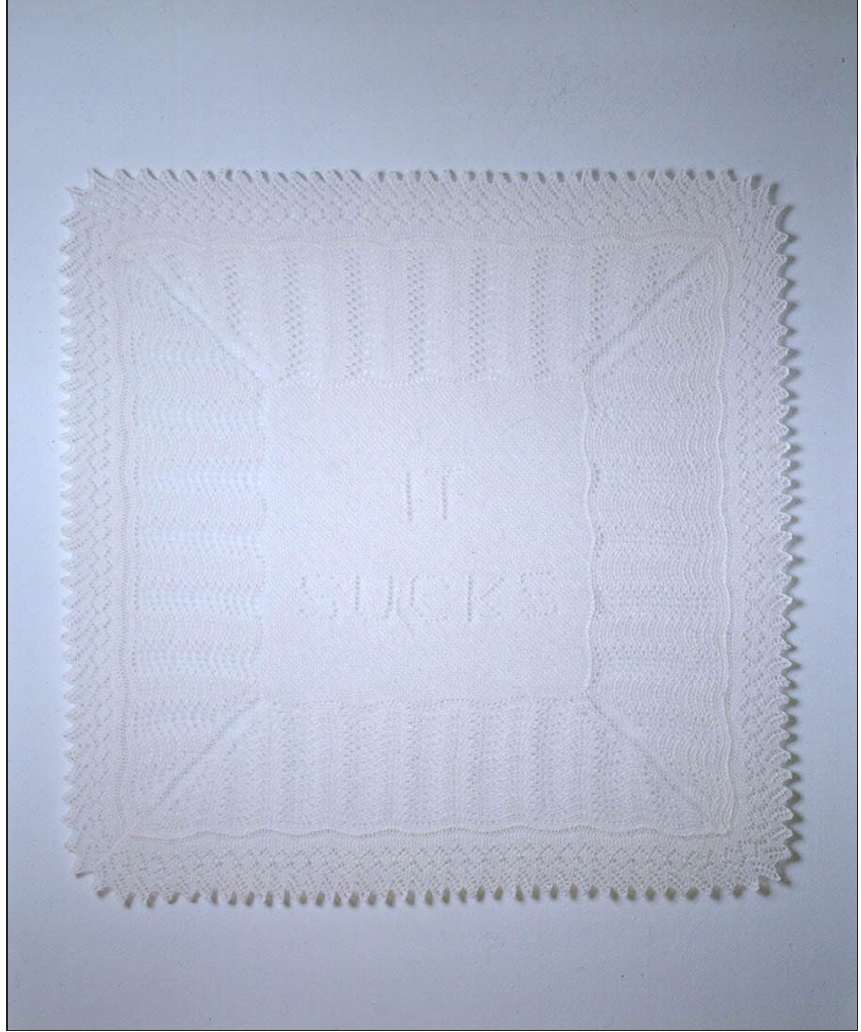
Figure 1: IT SUCKS , 2005, hand knitted 2-ply Shetland Lace Yarn, 1000 × 1000 mm. Knitted for me by Audrey Yates. Photograph: Colin